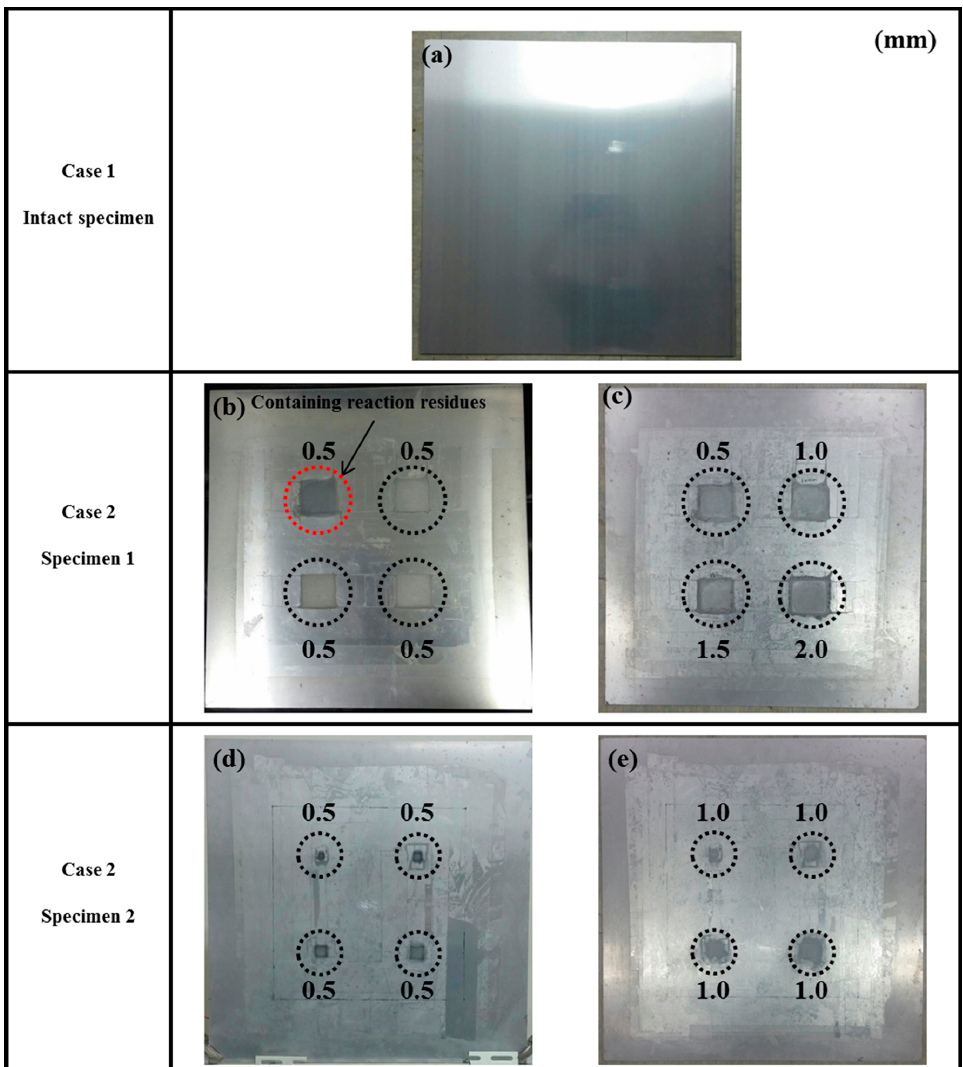
Figure 6. Dimensions of corroded areas: ( a ) intact specimen; ( b ) Specimen 1 (all depths = 0.5 mm); ( c ) Specimen 1 (depths = 0.5, 1.0, 1.5, and 2.0 mm); ( d ) Specimen 2 (all depths = 0.5 mm); ( e ) Specimen 2 (all depths = 1.0 mm).